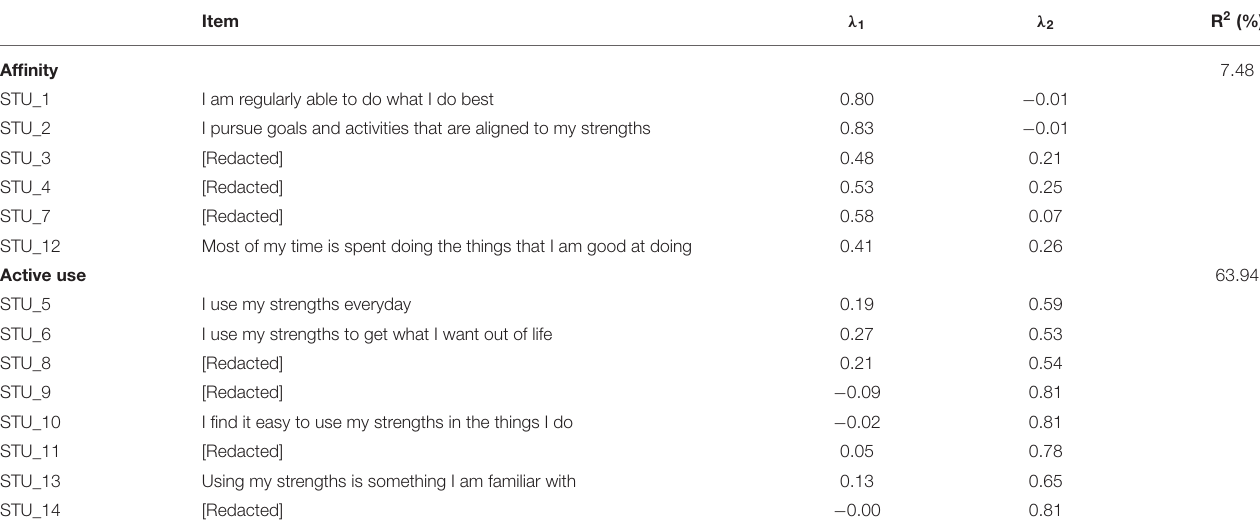
TABLE 3 | EFA: Geomin rotated factor loadings and declared variance.